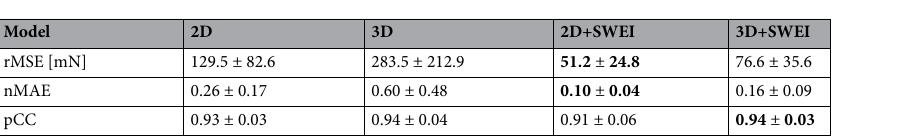
Table 3. Evaluation metrics for all models trained on phantom data and tested on ex-vivo soft tissue. Results are averaged for all tissue samples and best results are marked